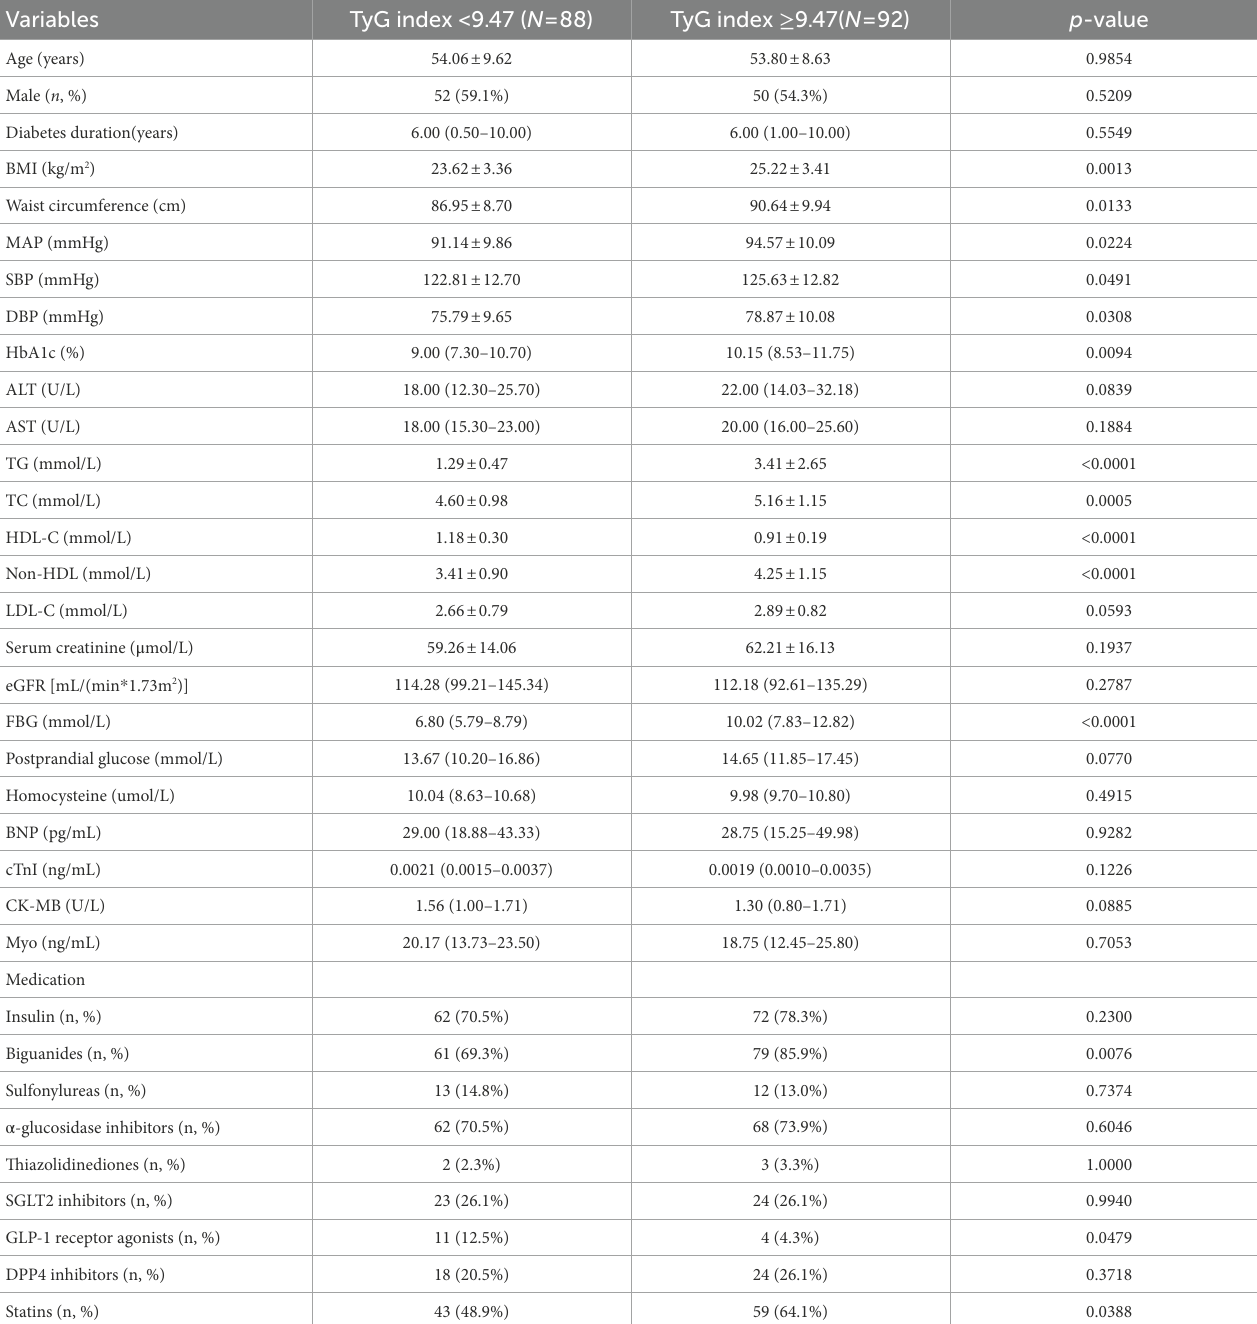
TABLE 1 Clinical and metabolic characteristics in T2DM patients stratified by binary TyG index.